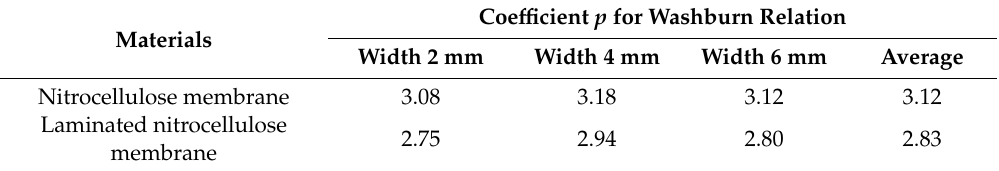
Table 6. Fitting coe ffi cient p of Washburn relation of NC